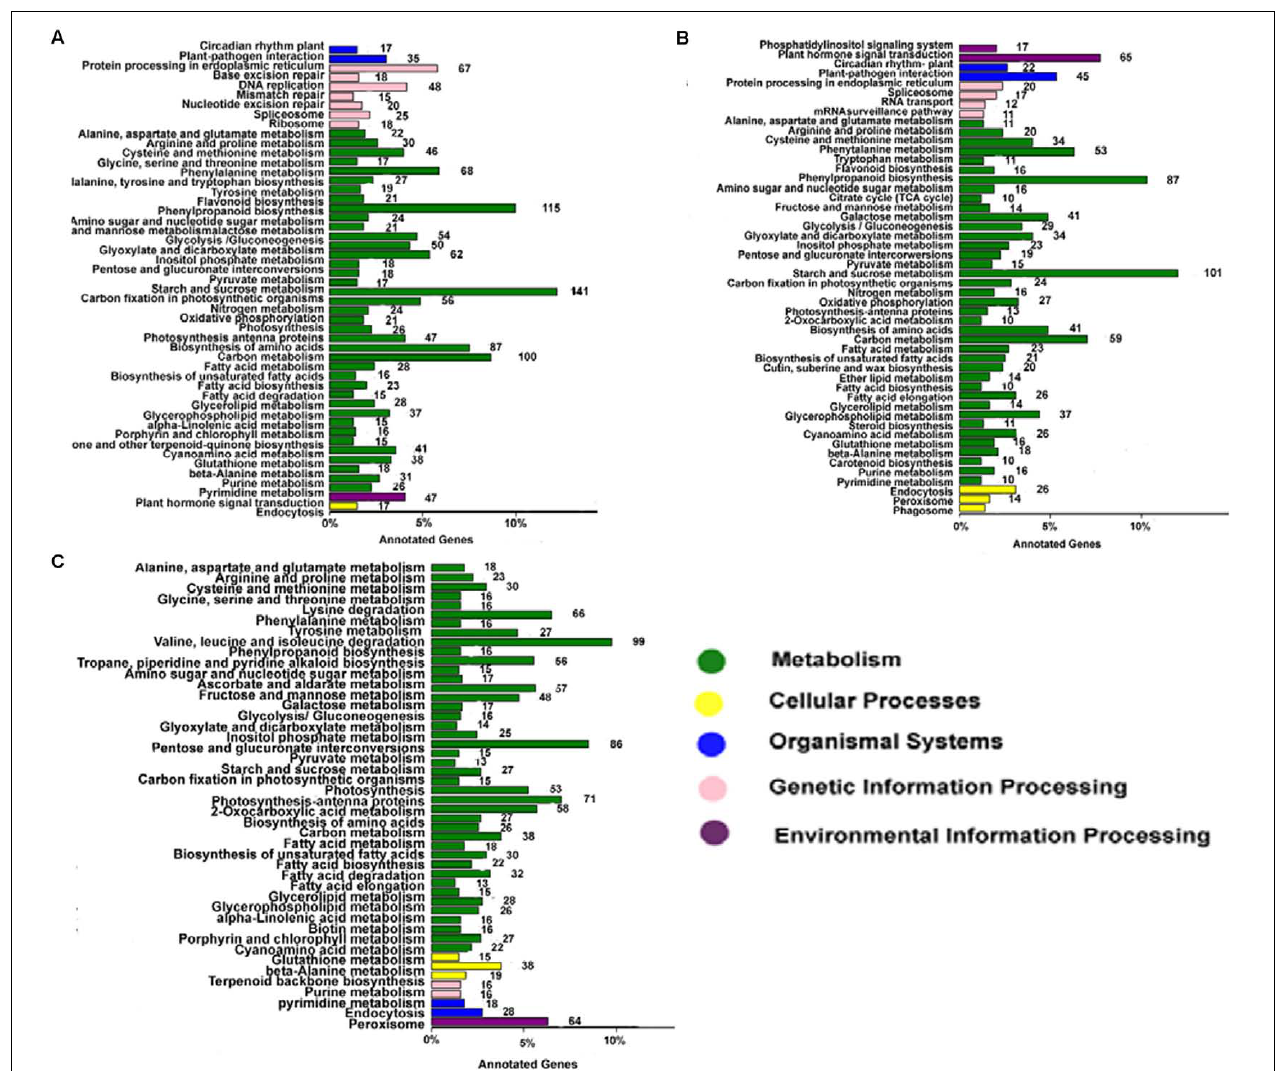
FIGURE 6 | KEGG classifications of DEGs. The vertical axis shows the annotations of the KEGG metabolic pathways. The horizontal axis represents the gene numbers annotated in each pathway and the proportion relative to the total number of genes. (A–C) Represent the KEGG pathway classifications for DEGs in AF relative to AS in the late uninucleate, binucleate, and trinucleate stages, respectively. Each color represents a KEGG pathway and relationships are shown on the right-hand